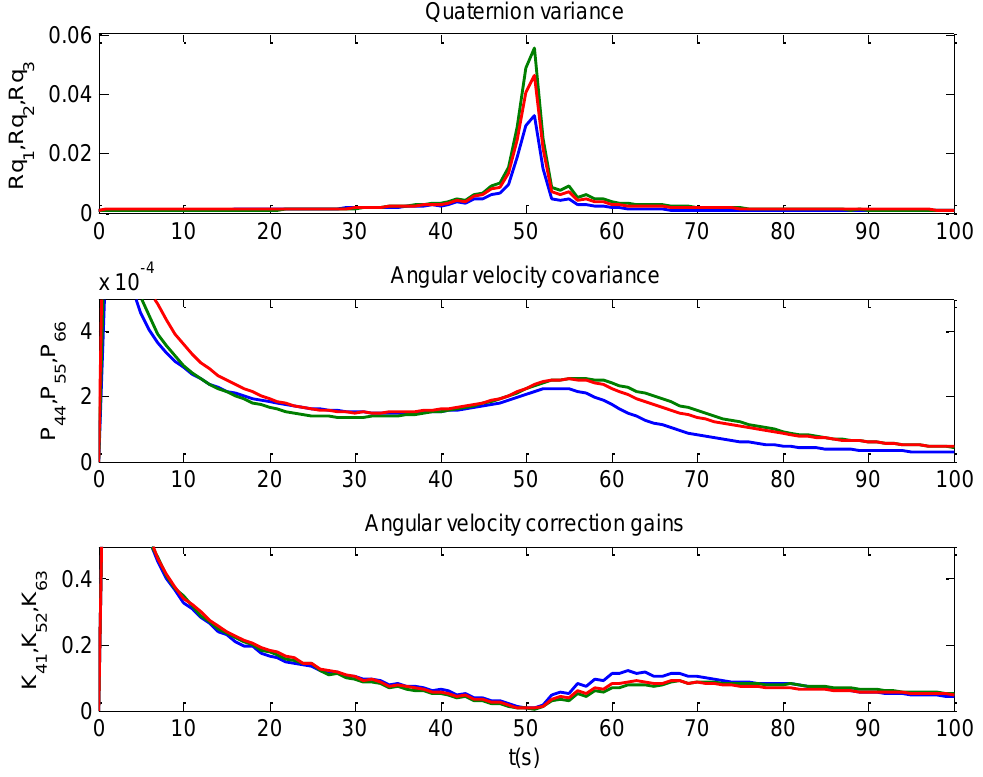
Figure 7. The plot on top shows the variances of the determined quaternion. The plot in the middle shows the main components of the covariance matrix of Kalman filter for the angular velocity. The plot at the bottom shows the main correction gains of Kalman filter for the angular velocity.